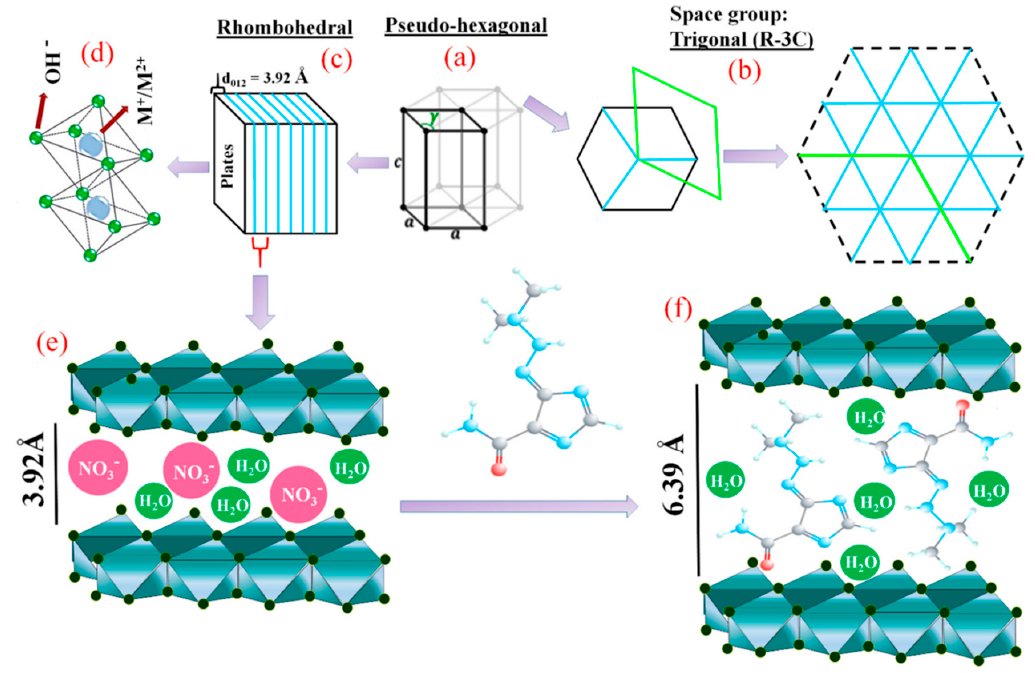
Figure 20. Schematic illustration of the structure of NaCa LDH for dacarbazine drug loading. NaCa LDH has ( a ) pseudo-hexagonal (P-3m1) structure with ( b ) a trigonal crystal structure (R-3C) and ( c ) rhombohedral lattice system. ( d ) The M 2+/ M + ions are surrounded approximately octahedrally by hydroxide ions, ( e ) structure of NO 3 LDH, and ( f ) structure of the LDH intercalated with dacarbazine drug, showing an enlargement of the inter-layer spacing. Reprinted from Ref. [240], with permission from Elsevier.